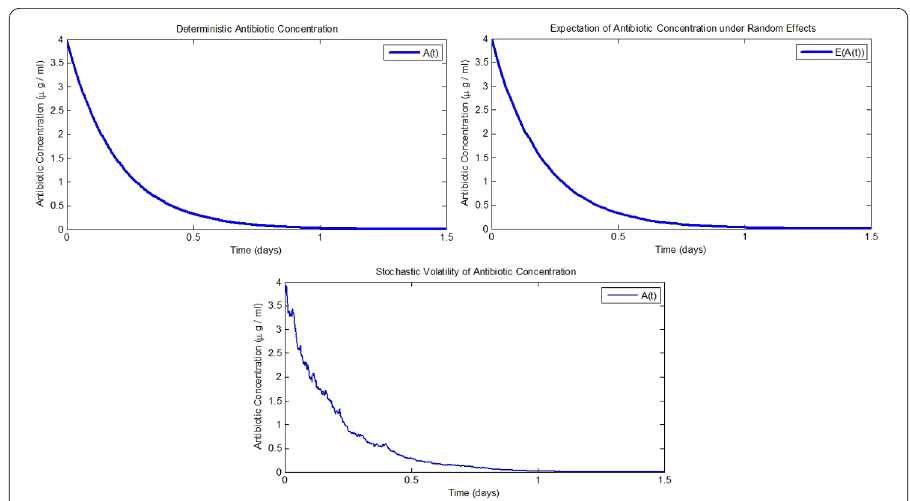
Figure 14 Deterministic, random and stochastic results for A ( t ), respectively.